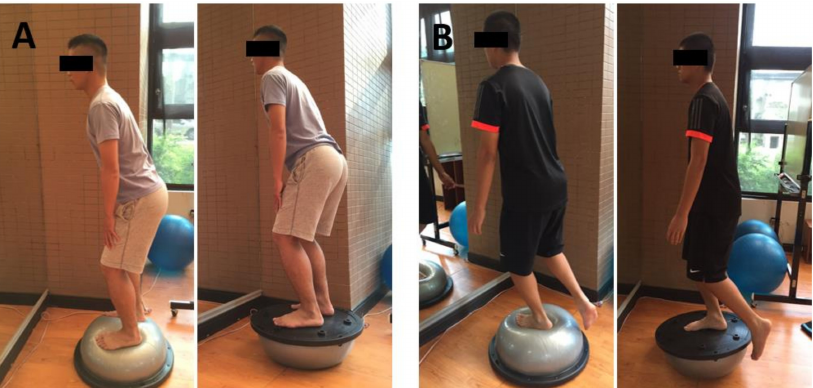
Figure 1. ( A ) Balance training in the initial phase. Subject performed bilateral leg stance exercises on the BOSU balance device. ( B ) Balance training in the late phase. Subject performed single leg stance exercises on the BOSU balance